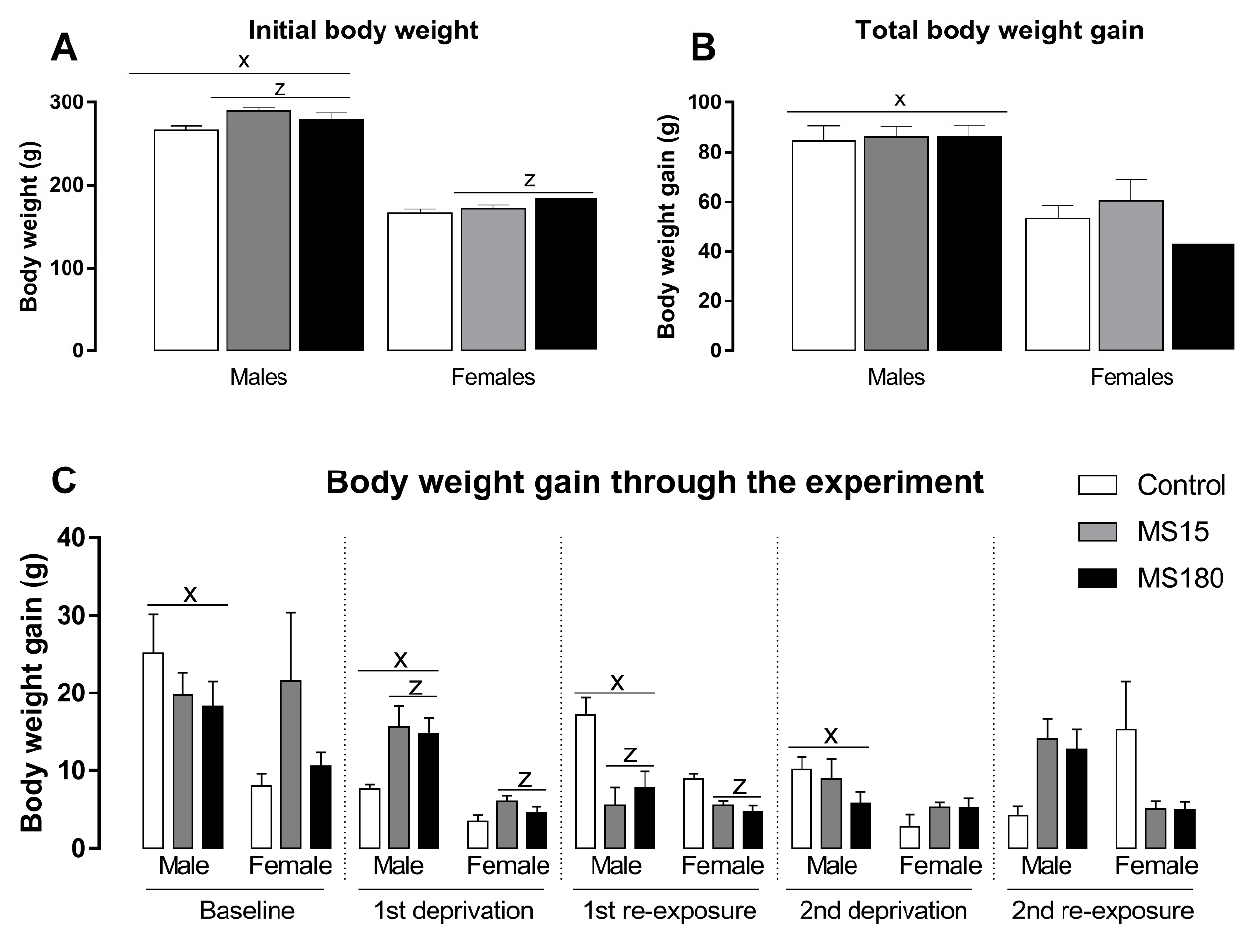
Figure 5. Initial body weight and body weight gain through the experiment in female and male rats exposed to brief and prolonged maternal separation. Bars represent the mean ± SEM (n = 11–14 animals/group). ( A ), initial body weight (g). ( B ), body weight gain during the whole period of alcohol deprivation effect (g/kg). ( C ), body weight gain in different phases of the alcohol deprivation effect protocol (g/kg). Body weight gain was calculated as the difference between the body weight on the last day of the respective phase and the first day of the same experimental phase. x; p < 0.05 when compared to female groups, independent of the manipulation; z, significant effect of maternal separation, regardless of sex. MS15, brief maternal separation; MS180, prolonged maternal